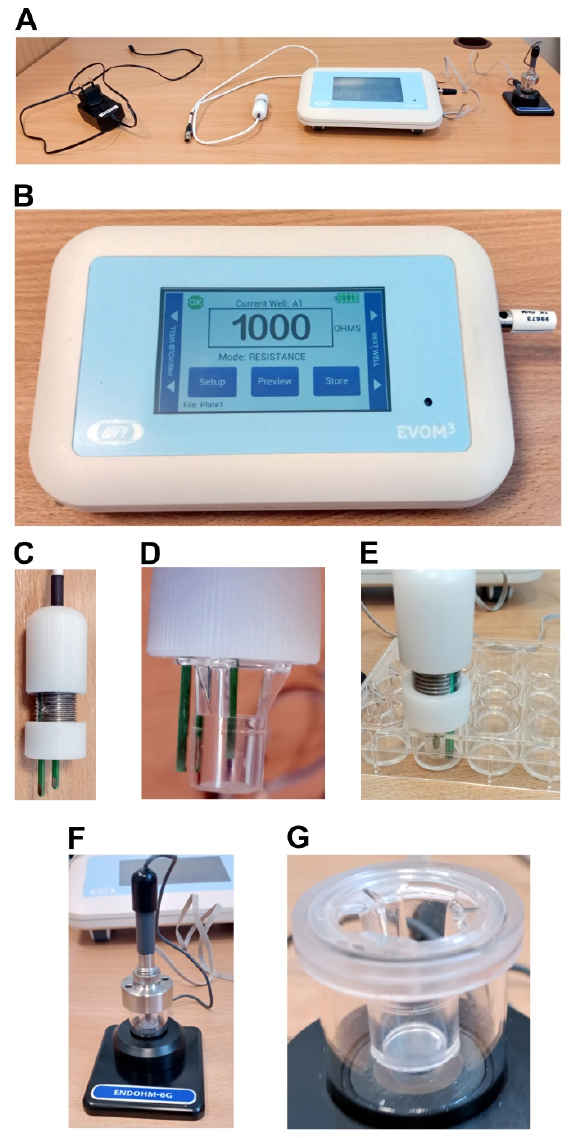
Figure 2. The overview of EVOM3 (epithelial volt–ohm meter) system with all its components, used for the transepithelial/transendothelial electrical resistance (TEER) measurements (from left to right: A/C power supply and charger, STX2-Plus electrode, EVOM3 meter and the optional Endohm-6G chamber electrode). ( A ) the general view of the whole EVOM3 system. ( B ) The EVOM3 meter with the 1 kOhm test resistor inserted into the electrode port: the display shows the actual resistance of the test resistor. ( C ) The body of the STX2-Plus chopstick electrode. ( D , E ) The proper adjustment of STX2-Plus electrode to fit the insert with a 6.5 mm diameter (compatible with 24-well plates):